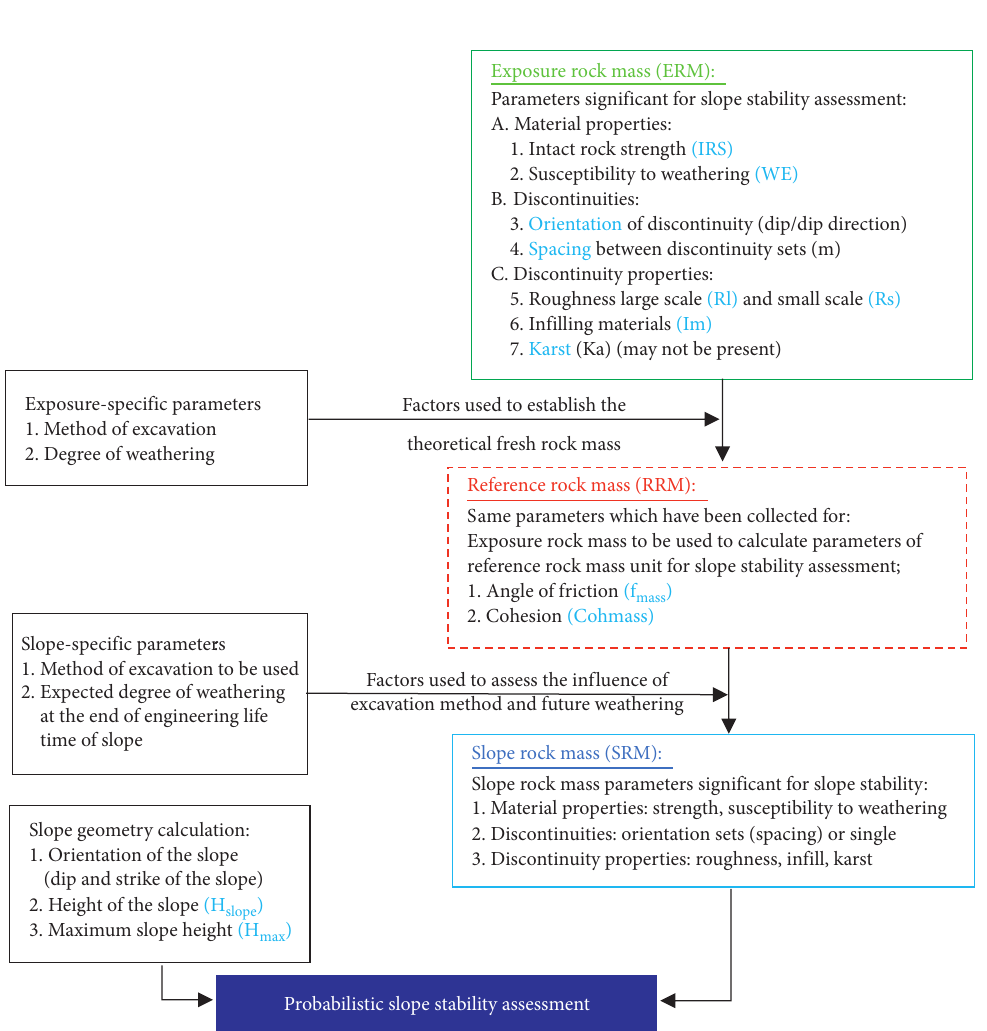
Figure 5: Flowchart of the SSPC method (modified after Canal A and Akin M,